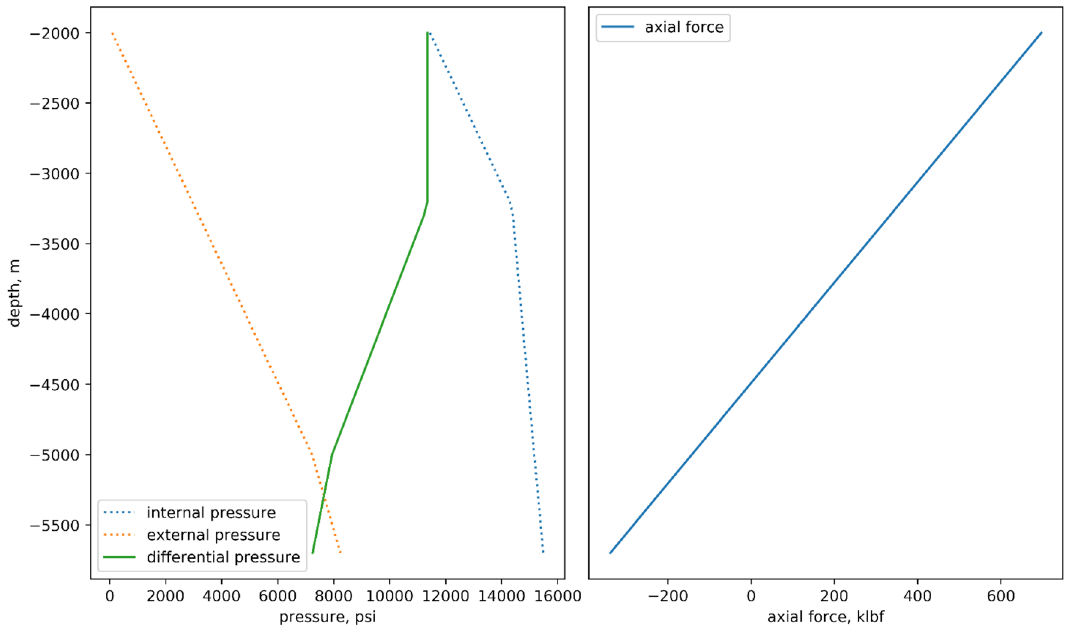
Fig. 12 Loading profile on the adopted